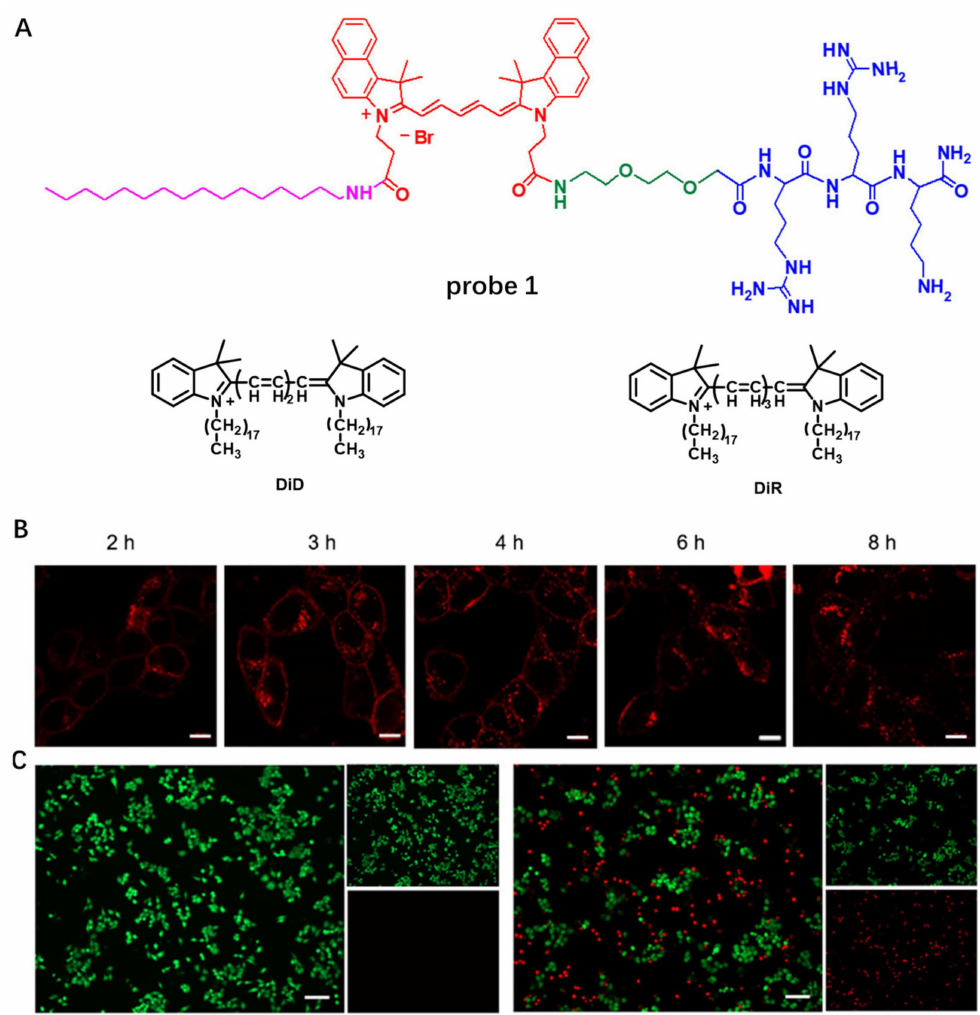
Figure 1. ( A ) Chemical structures of probe 1 , DiD and DiR. ( B ) Live cell imaging using probe 1 . Scale bar: 10 µ m ( C ). Photo-thermal ablation of tumor cells with probe 1 . Copyright 2020 Springer Nature